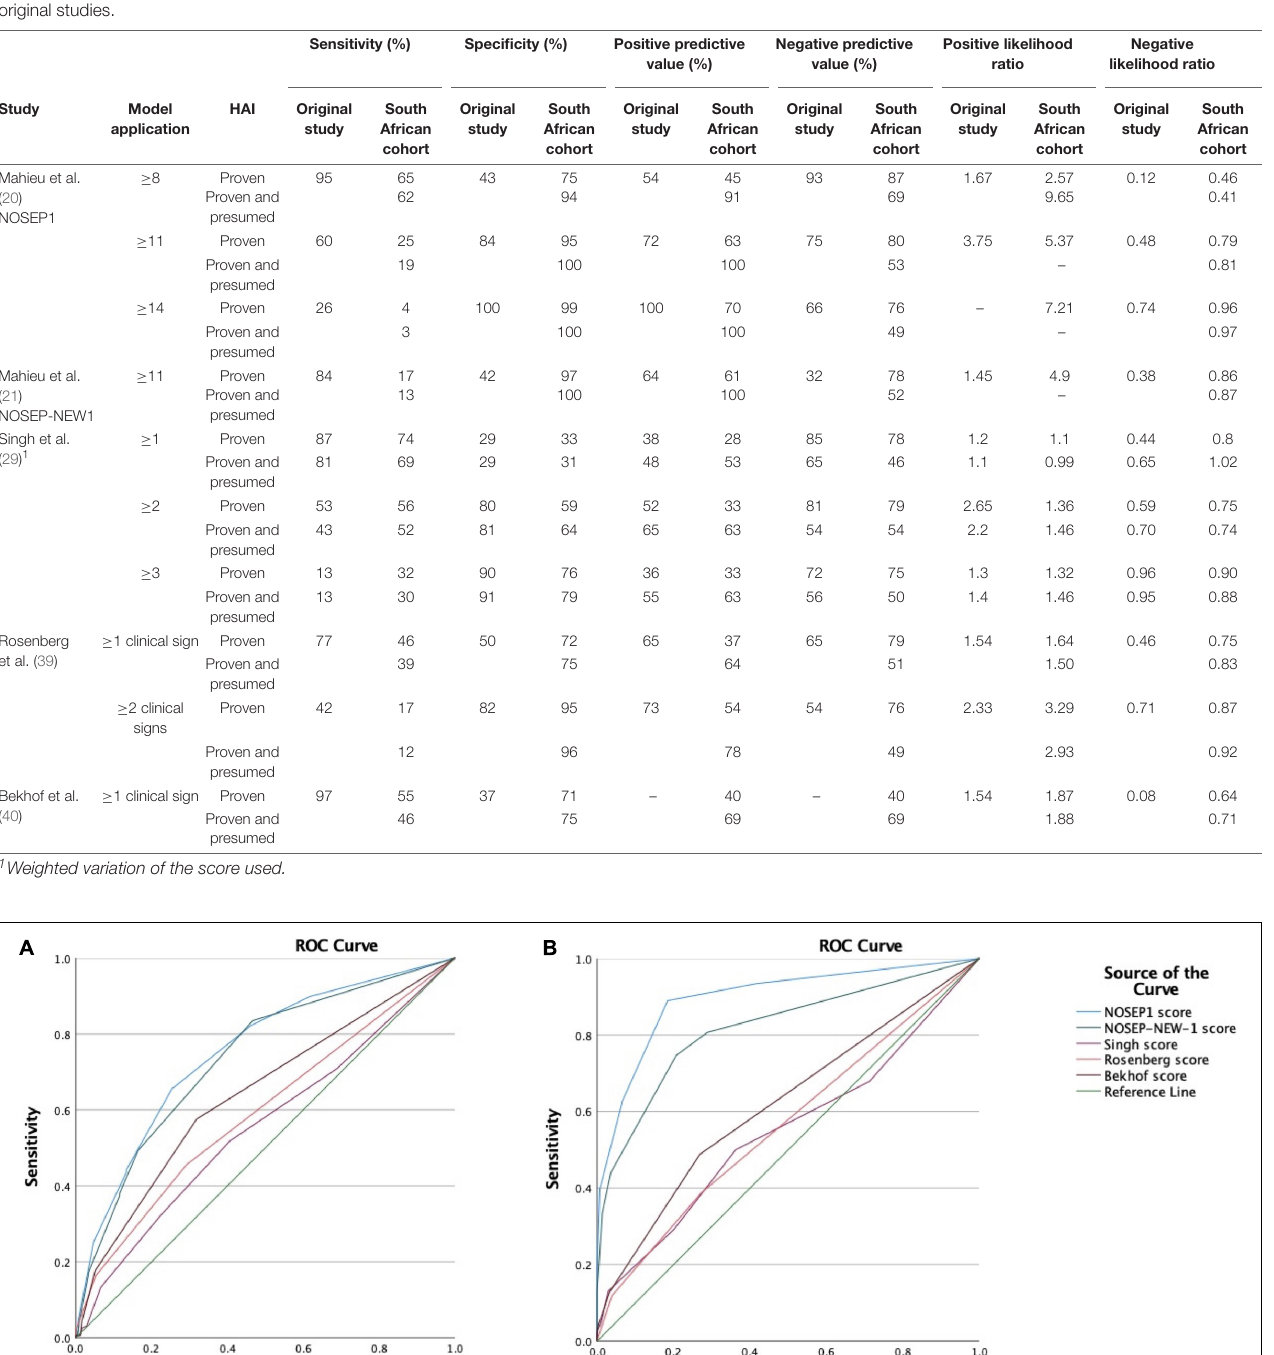
TABLE 4 | Performance comparison of previously reported infection prediction scores in very low birth weight infants at a South African neonatal unit, compared to the original studies.